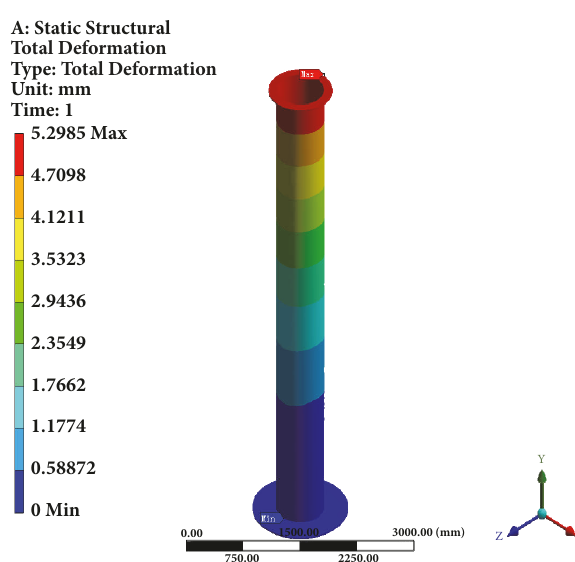
Figure 14: Total deformation contour of tower.